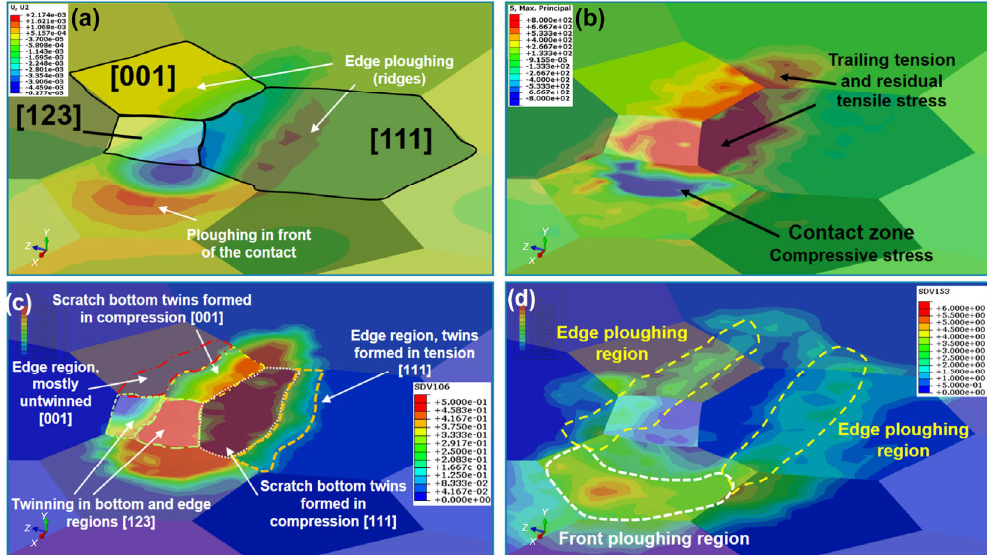
Fig. 5 (a) In-depth displacement during the simulation and specific orientations of the grains, (b) 1st principal stress contour, (c) twin volume fraction (red is 0.5), and (d) number of currently active twin systems (red is